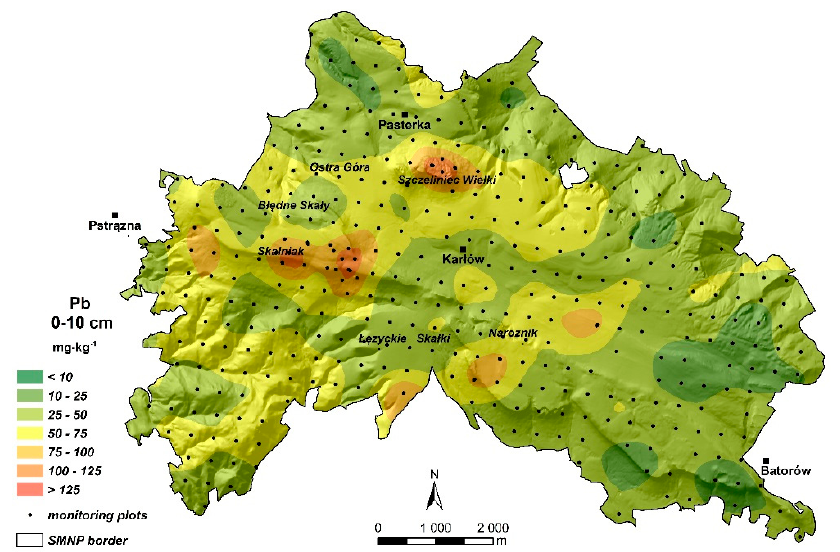
Figure 7. Prediction map of the spatial Pb distribution, developed by simply kriging for the reduced and extended monitoring network (REMNet).